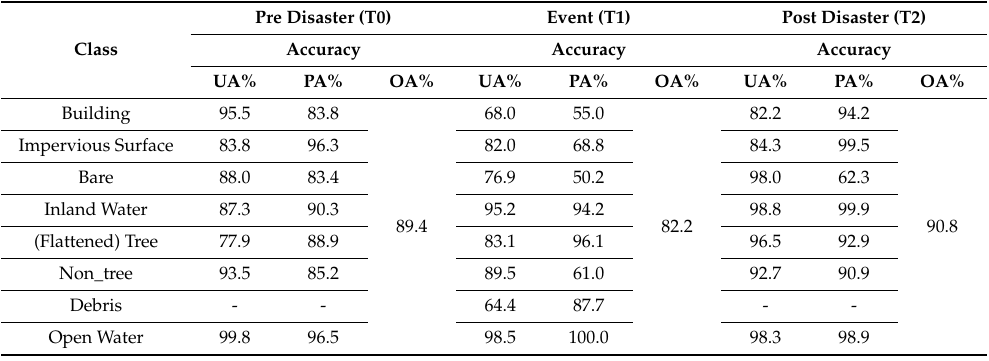
Table 6. Comparison of LC classification accuracies for pre-event and post-disaster situations. User and producer accuracies and corresponding errors are computed across the study area by combining the confusion matrices of T0, T1, and T2.